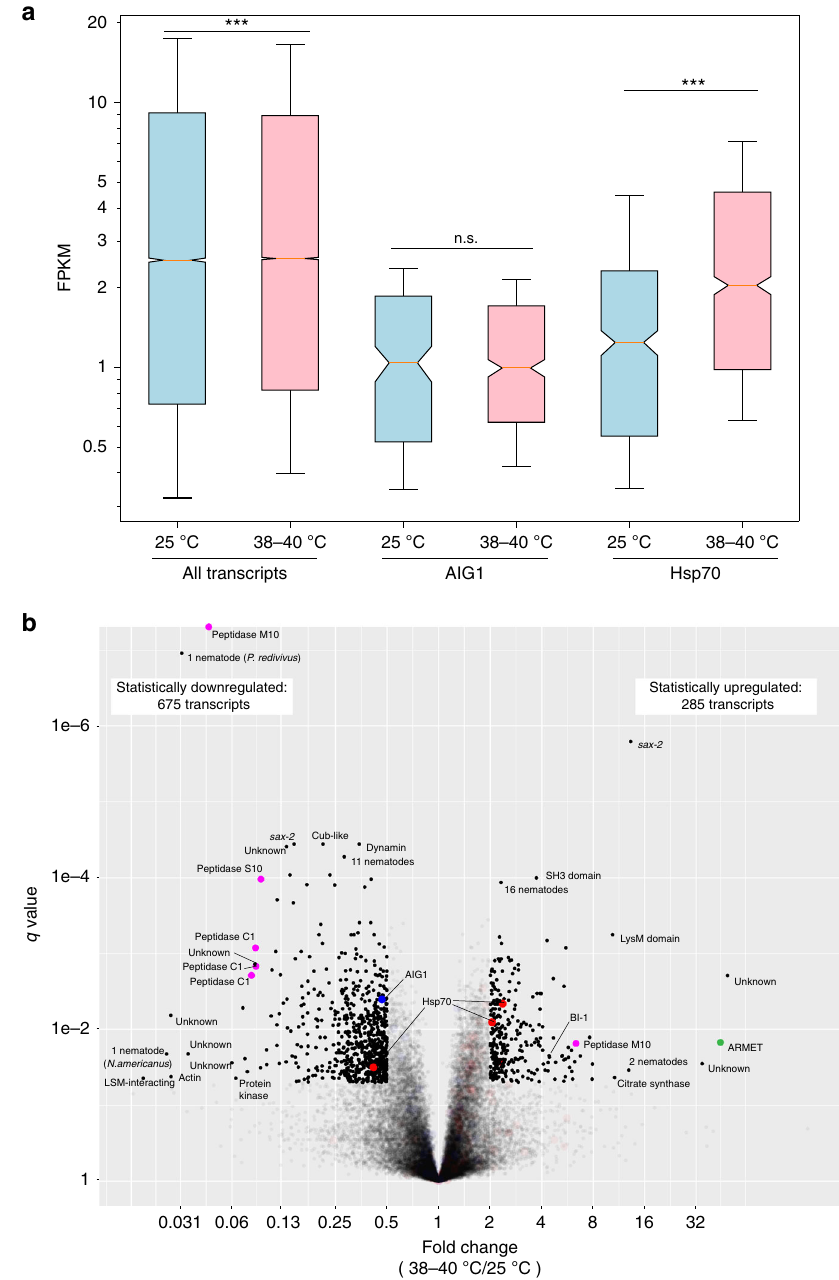
Fig. 4 Transcriptome analysis of gene expression in H. mephisto . a Boxplot showing that Hsp70 transcripts are induced on heat while AIG1 transcripts are unchanged. Box shows median (center line) and fi rst and third quartiles, while whiskers indicate the 15th to 85th percentiles, and notches represent con fi dence intervals. p Values obtained by two-tailed Mann – Whitney test. Source data are provided as a Source Data fi le. b Volcano plot of gene expression fold change comparing heat (combined replicates: 38°, n = 3, and 40°, n = 6) versus 25 °C control (replicates, n = 3). Statistically altered transcripts, de fi ned as q value less than 0.05 and upregulated or downregulated at least twofold under heat-stress conditions (38 – 40 °C) relative to 25 °C controls, are indicated with luminosity of 1 while nonsigni fi cant are luminosity 0.1. The q value was obtained from the stattest() function within the Ballgown R package. Genes labeled “ Unknown ” are novel, as discussed in the text. Proteins encoding no recognizable domain but matching other nematodes by blastp are indicated with the number of nematode species matched (out of the 28 used in constructing the blast database). For genes matching only a single other nematode, the species is given in parenthesis. Color key: red: Hsp70, blue: AIG1, green: ARMET, and magenta: